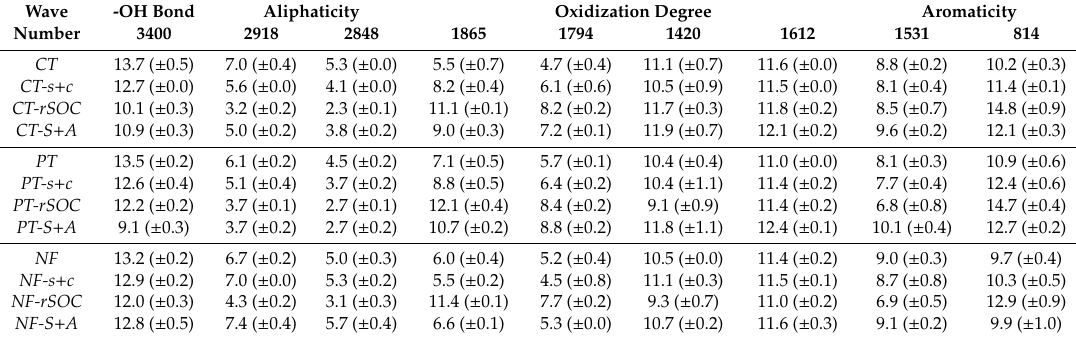
Table 2. Mean relative absorbances at the investigated wavenumbers in the soil fractions; standard deviations are in brackets (CT: conservation tillage; PT: ploughing tillage; NF: native forest; S + A: sand and aggregates; s + c: fine fraction ( < 20 µ m); rSOC: resistant part of organic carbon attached to s + c ( n =